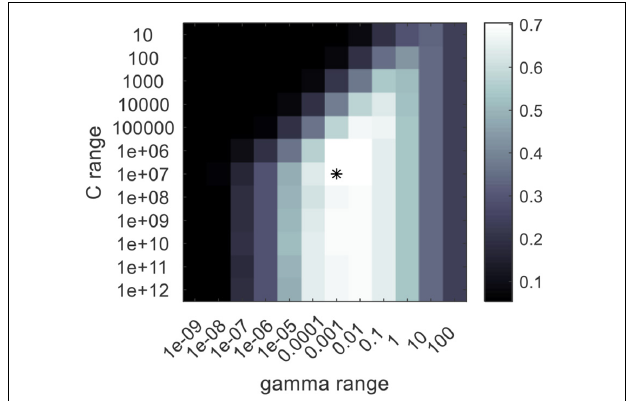
FIGURE 5 | The grid search result for the optimization of the radial basis function support vector machine classifier (RBF-SVC) model. The best combination of the RBF-SVC parameters is marked by